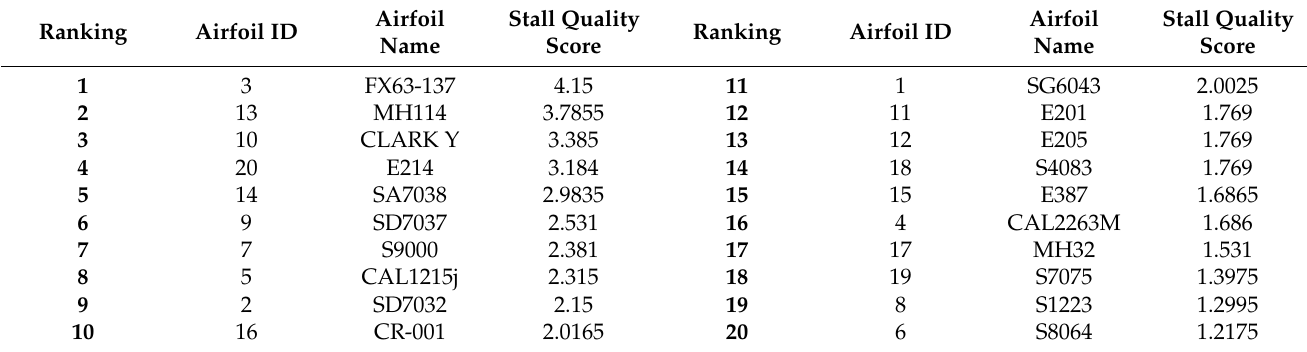
Table 11. Table S1 (in Supplementary Materials). Airfoil stall quality score.